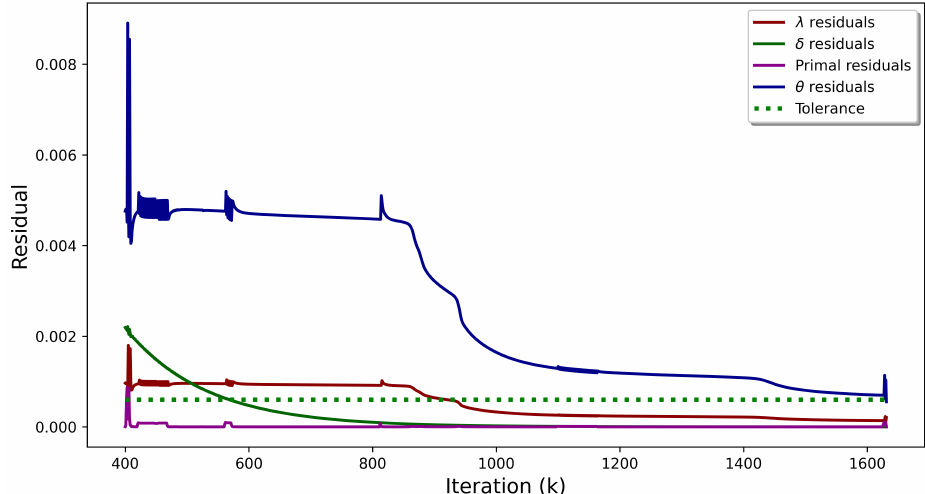
Figure 6. ADMM dual variables convergence rates from iteration 400 to 1632.